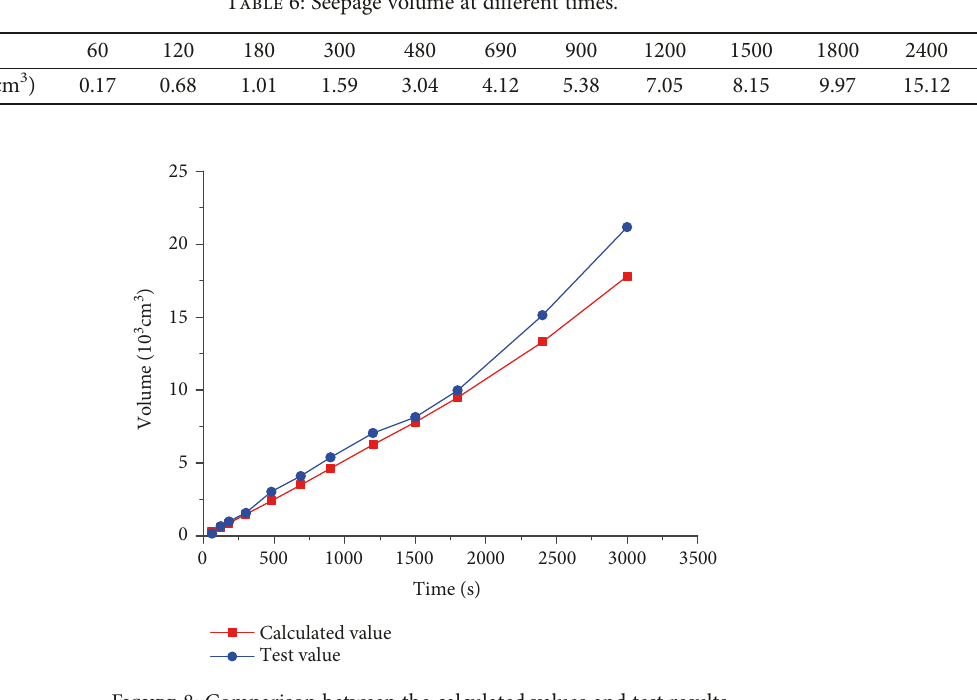
Figure 8: Comparison between the calculated values and test results.